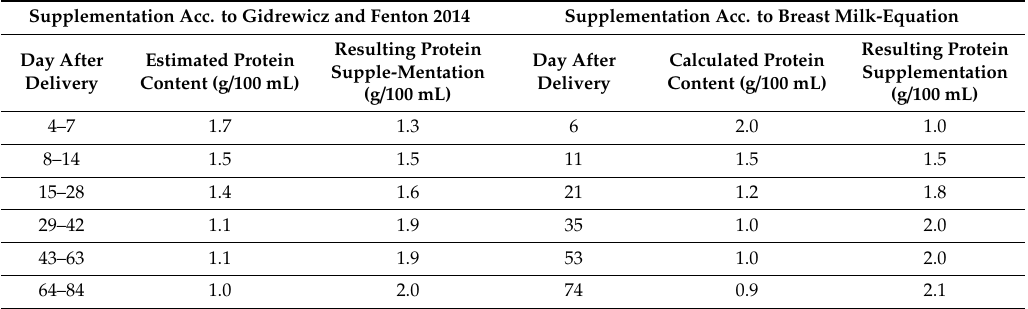
Table 1. Protein content of breast milk from mothers who delivered preterm in a meta-analysis performed by Gidrewicz and Fenton [11] and resulting supplementation to meet the targeted area of protein supply (2.7–3.3 g protein / 100 mL breast milk) compared to protein content of breast milk, calculated by use of the breast milk-equation (g / 100 mL breast milk) and resulting supplementation.